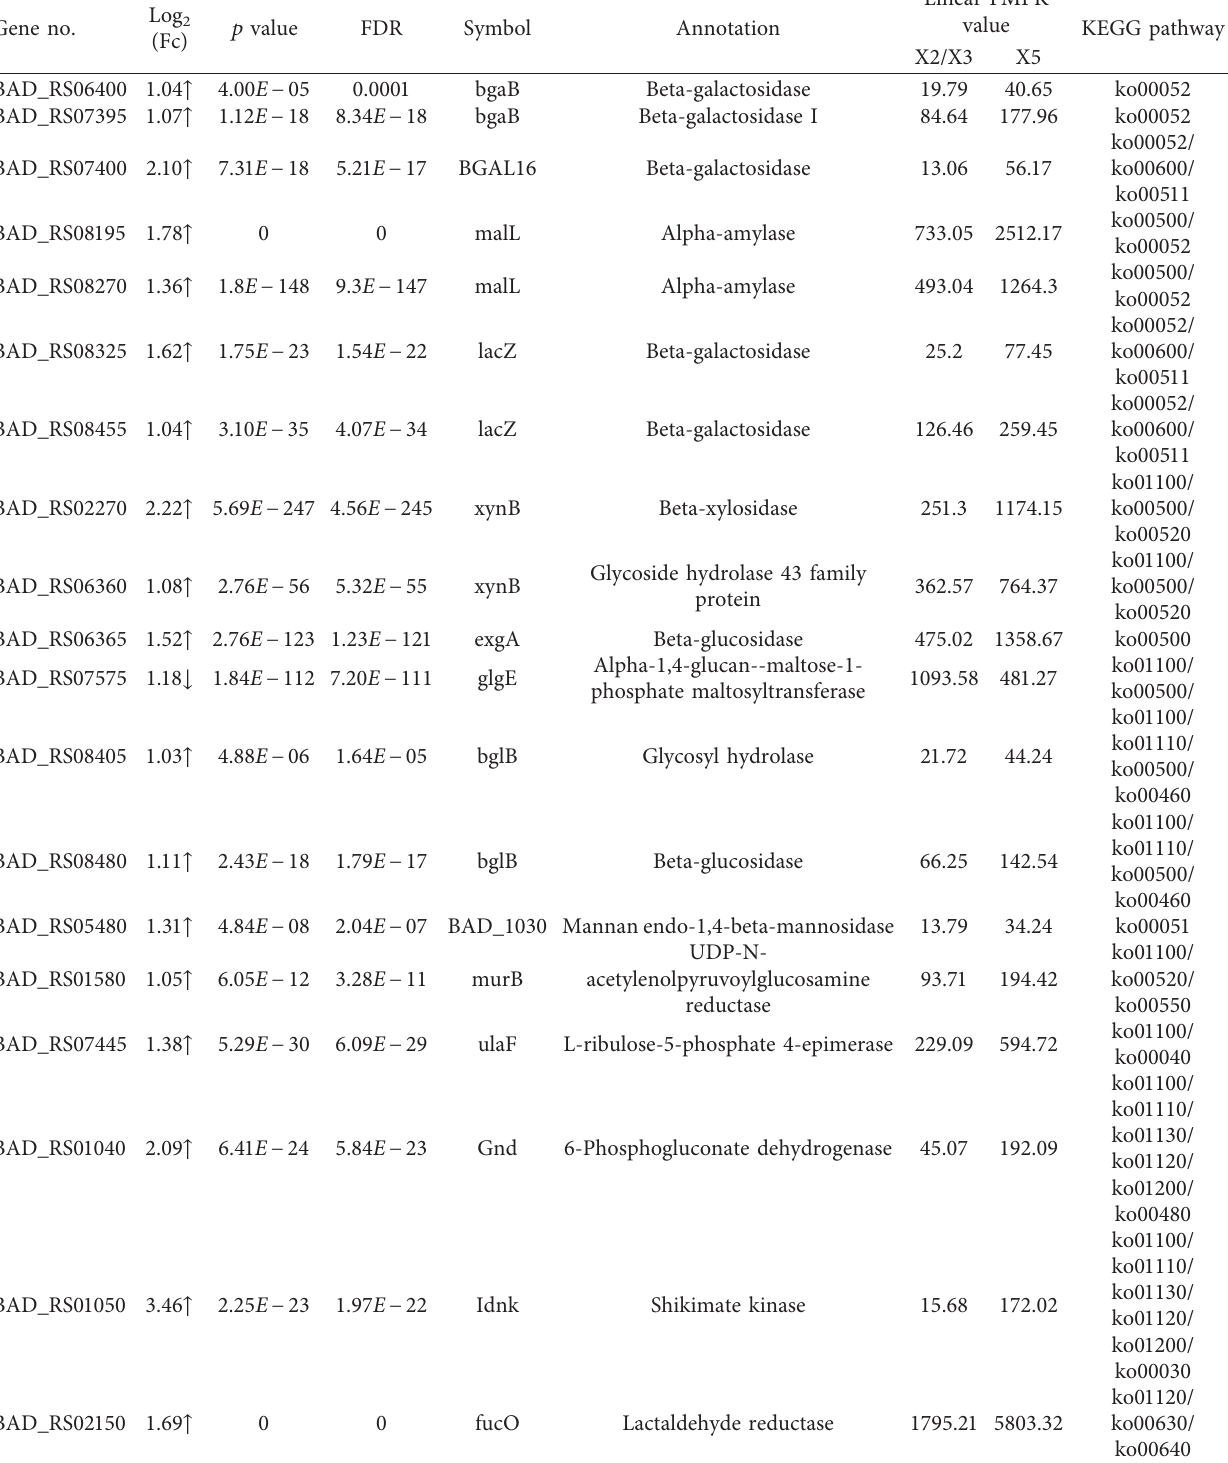
Table 2: DEGs involved in related carbohydrate metabolism in the KEGG pathway during the growth of B. adolescentis on X5 compared to X2/X3 assessed by RNA-seq. Gene